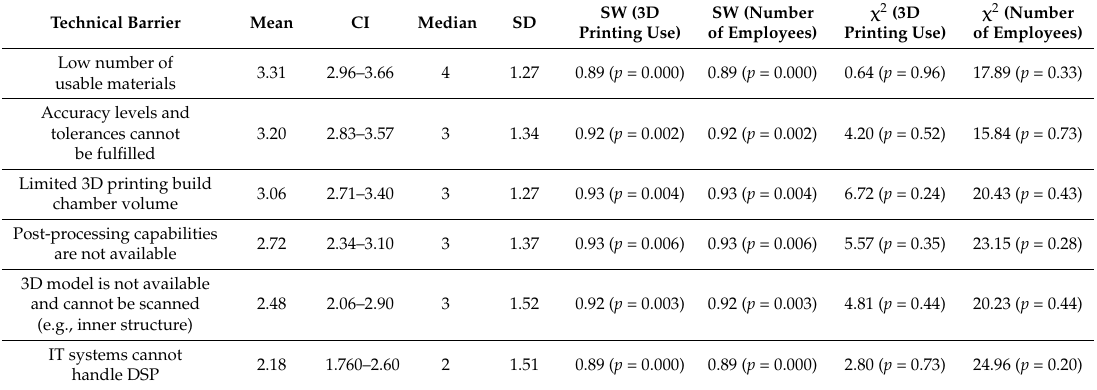
Table 2. Ranked technical barriers of digital spare parts (DSP), N = 50; CI = confidence interval, SD = standard deviation, SW = Shapiro Wilk, χ 2 = Chi-squared